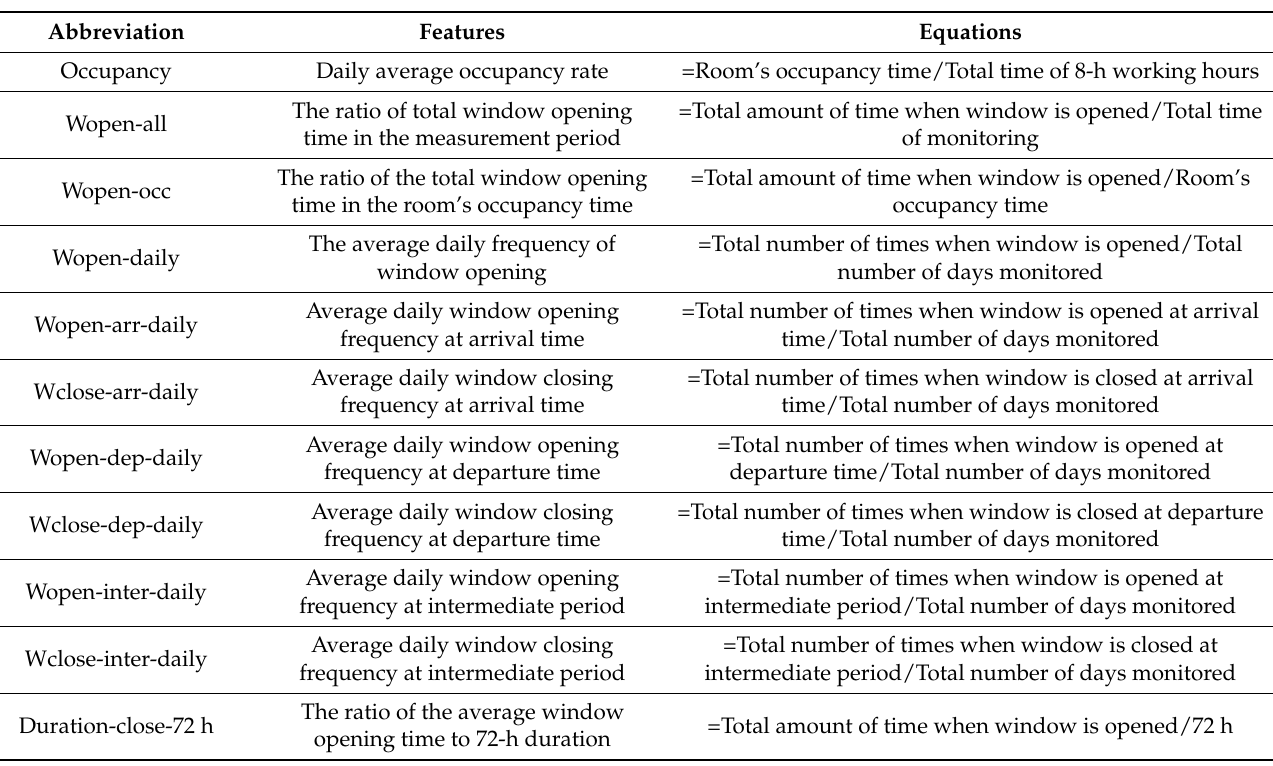
Table A1. Equations for 12